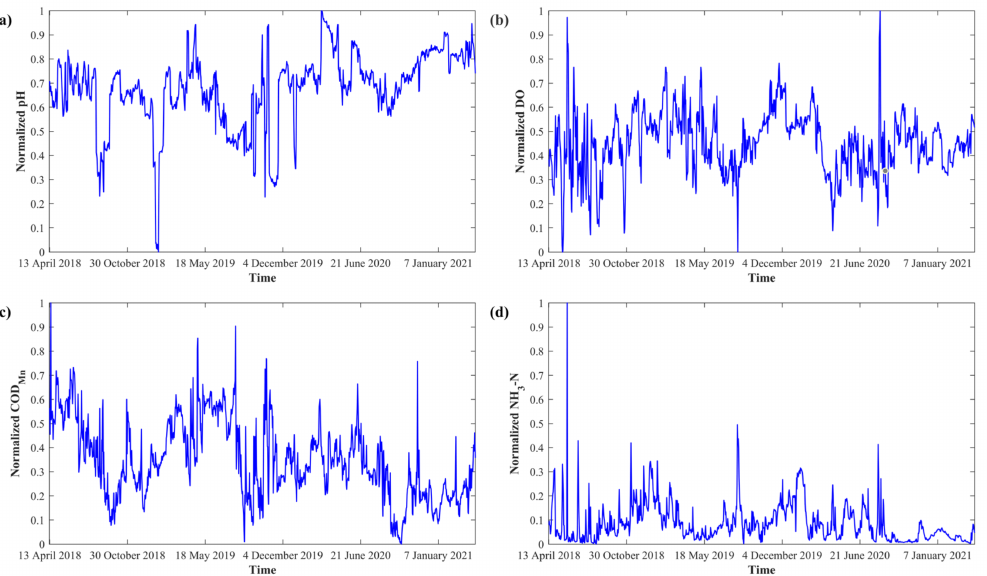
Figure 4. The normalization results of the water quality data: ( a ) pH, ( b ) DO, ( c ) COD Mn , and ( d ) NH 3 -N.